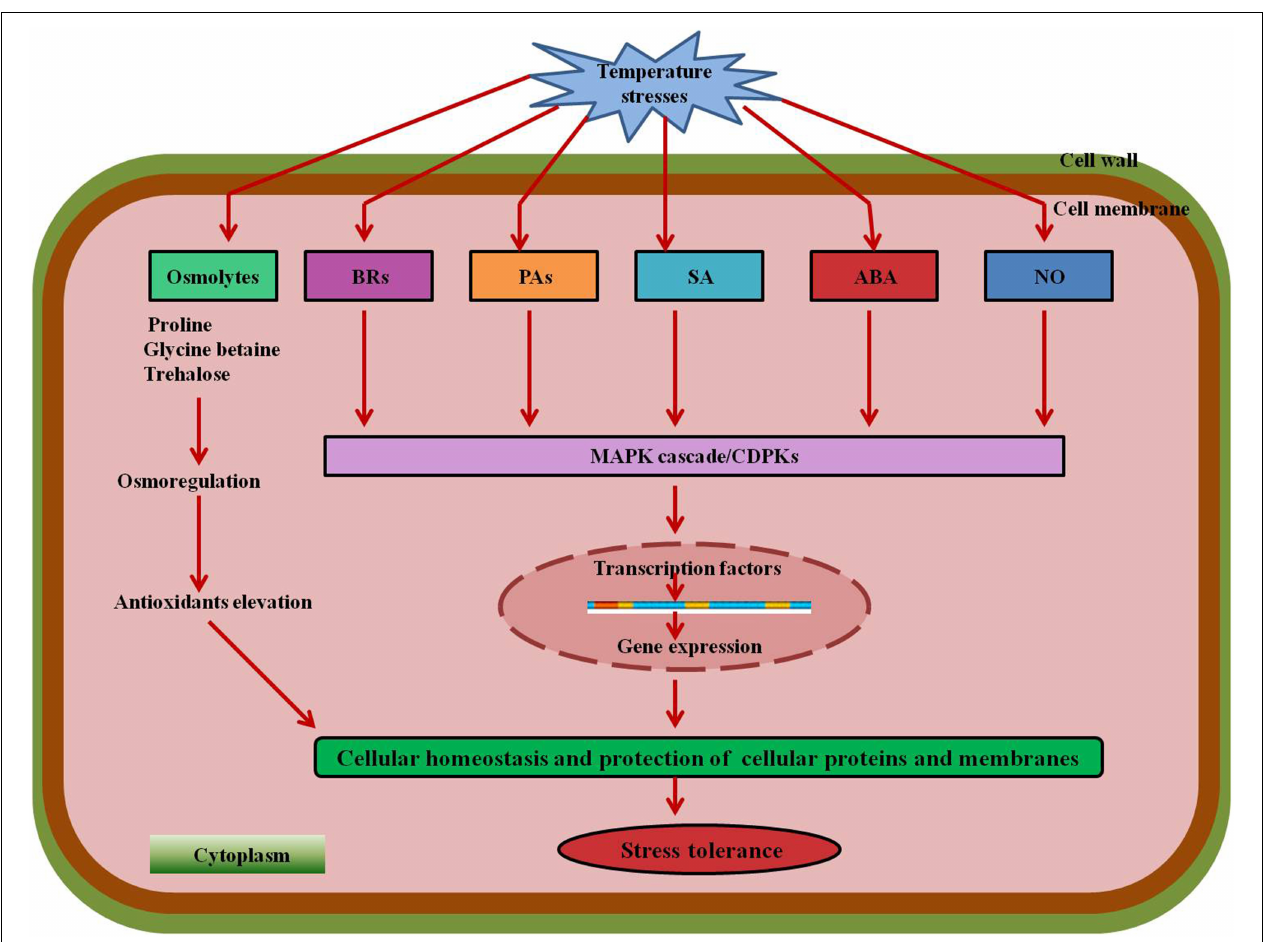
FIGURE 7 | A combined model showing the involvement of various signaling molecules and phytohormones under temperature stresses. Compatible solutes Pro, GB, and Tre mitigate stress by osmoregulation and production of antioxidants. BRs, PAs, SA, ABA, and other signaling molecules such as NO activate the MAPK cascade leading to regulation